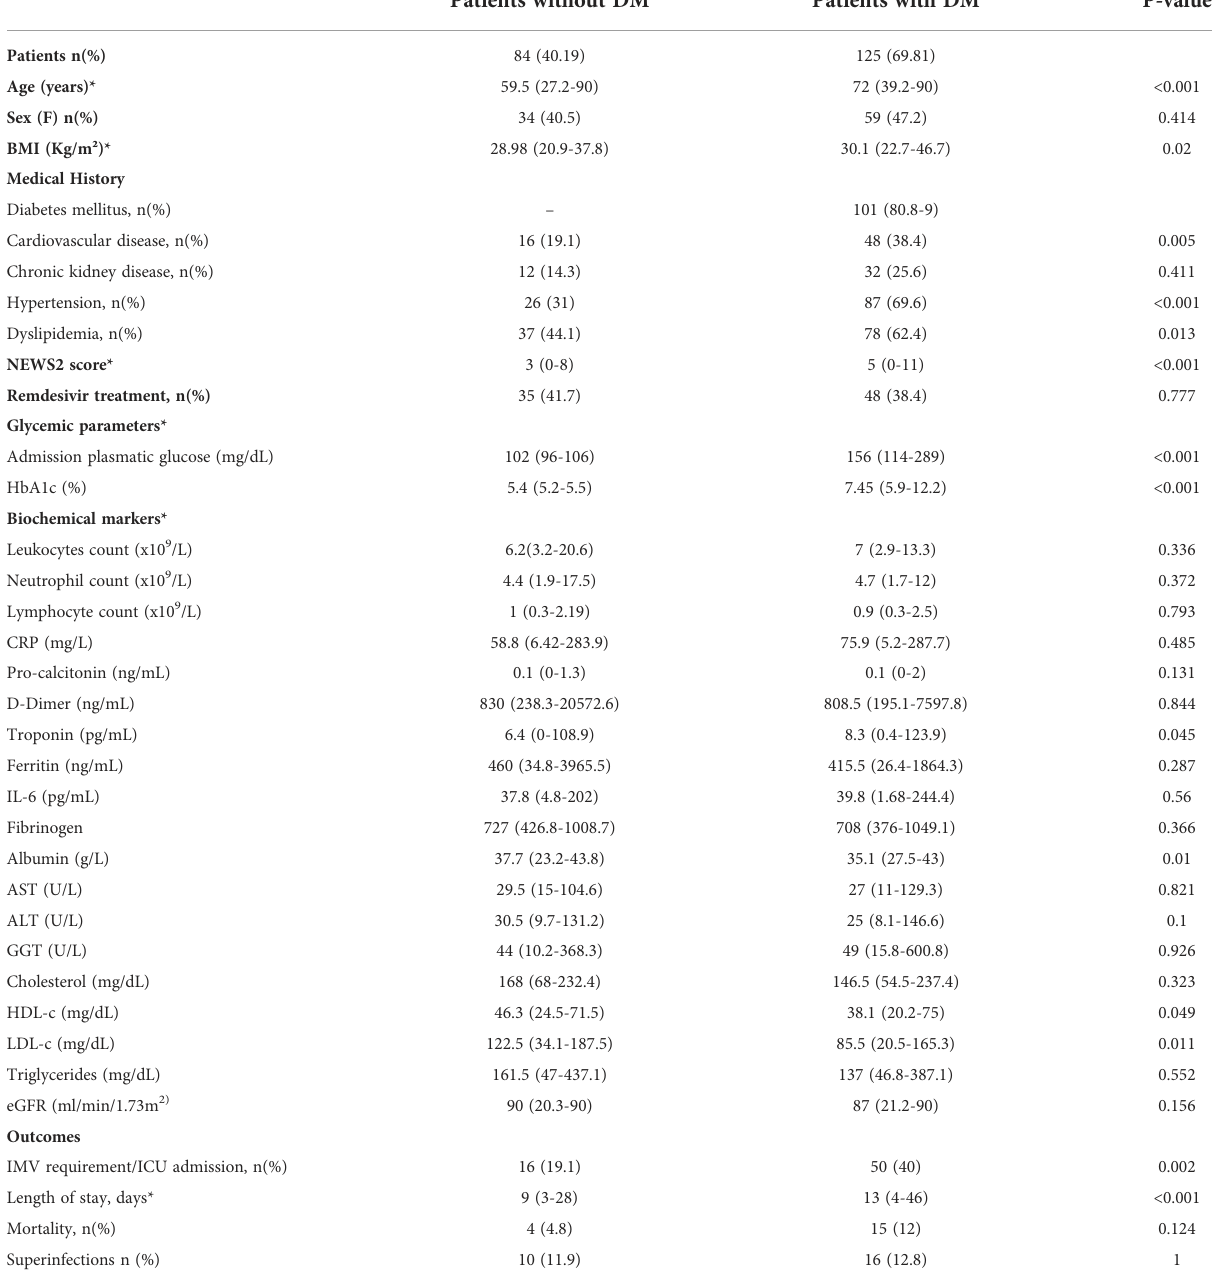
TABLE 1 Baseline clinical characteristics of patients with COVID-19 treated with dexamethasone. Patients without DM Patients with